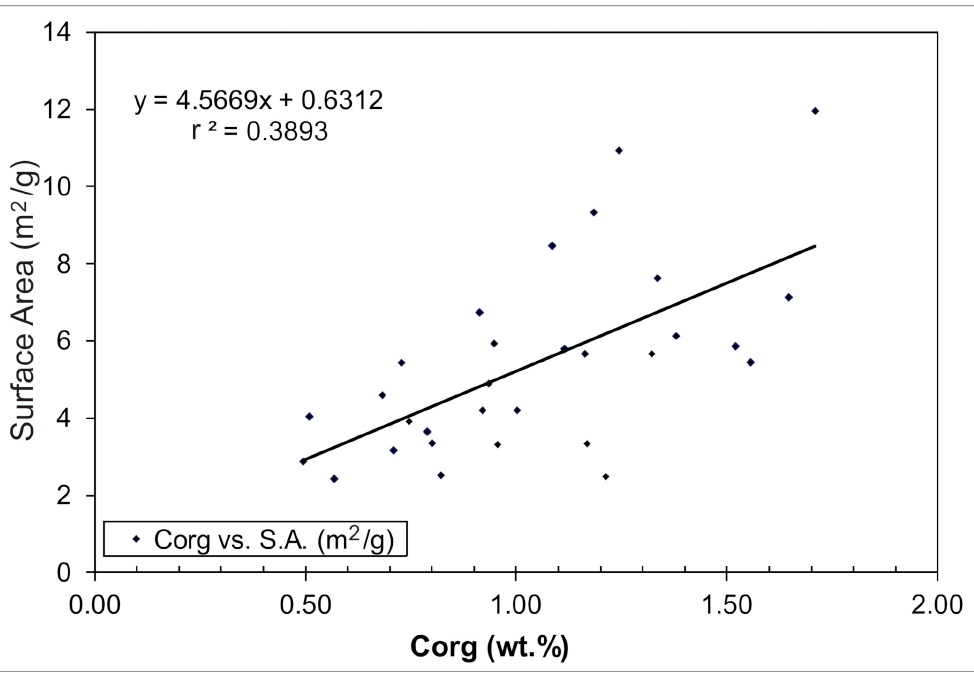
Figure 9. Plot of Surface Area (m 2 /g) versus Organic Carbon (C org ) for bulk sediment samples, showing a moderate positive linear regression, r 2 = 0.4. Table 5. Organic Carbon (C org ), Total Nitrogen (TN), Carbon/Nitrogen Ratio (C org /N) and Surface Area (SA) for sediment samples from selected depth intervals, size fractionated into five fractions: